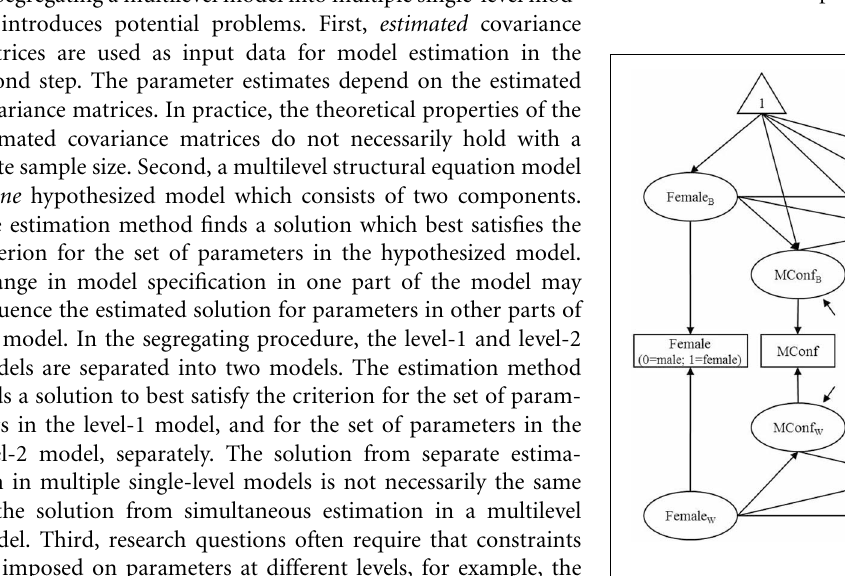
FIGURE 1 | A two-level path model of mathematics motivation, gender, and achievement. MConf, self-confidence; MUtil, student’s valuing or utility; MInt, student’s interest; MAch, mathematics achievement. Female: 1 = female; 0 = male. At level 2, MConf B , MUtil B , and MInt B are correlated with one another. At level 1, MConf W , MUtil W , and MInt W are correlated with one